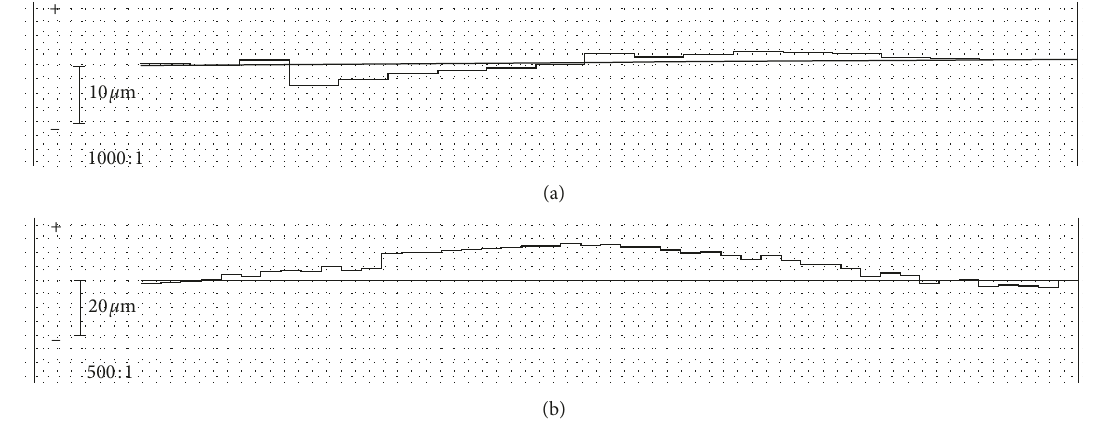
Figure 11: Measured cumulative pitch error: (a) pinion; (b) gear.